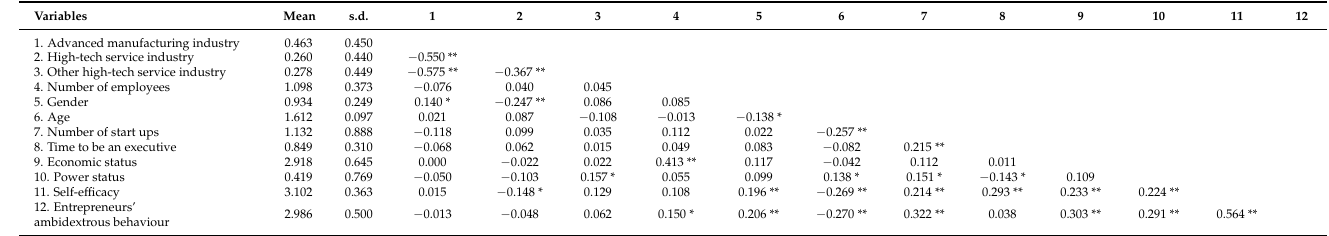
Table 1. Descriptive statistics and Pearson correlations among the